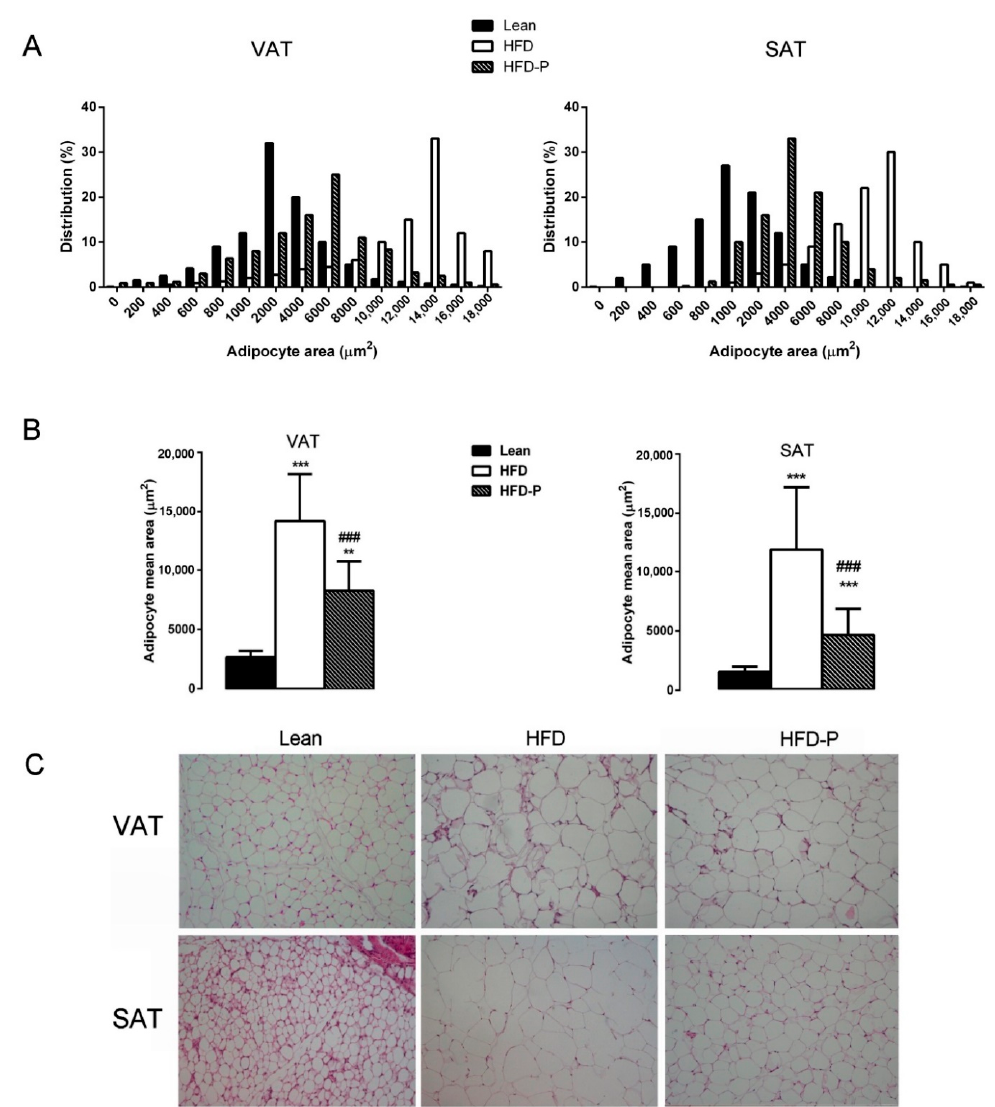
Figure 2. Effects of pistachio consumption on adipocyte morphology. ( A ) Adipocyte size distribution (%) and ( B ) adipocyte mean area ( μ m 2 ) of the epididymal visceral adipose tissues (VAT)